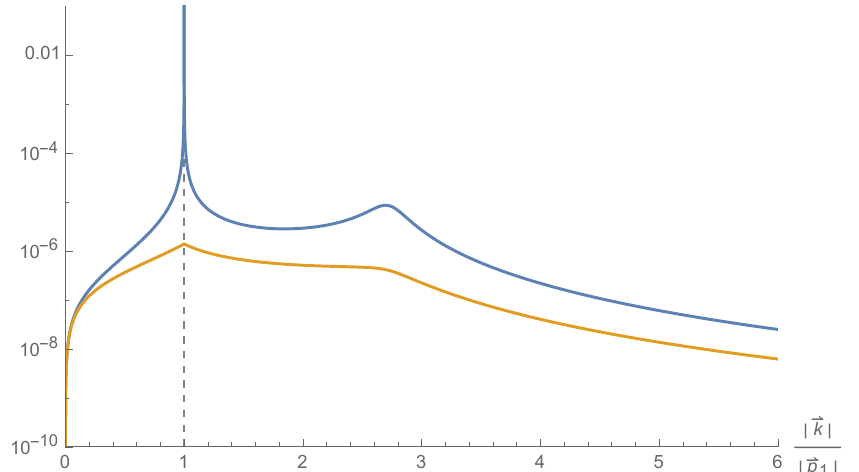
Figure 18. Multi-channelling for a triangle integral with massless propagators with momenta e = q i = k + p i , i 1 ; 2 ; 3 , such that ~p 3 = ~ 0: the LTD integrand 2 f g ~k 2 (orange) in spherical coordinates along the direction j j C f 3 g